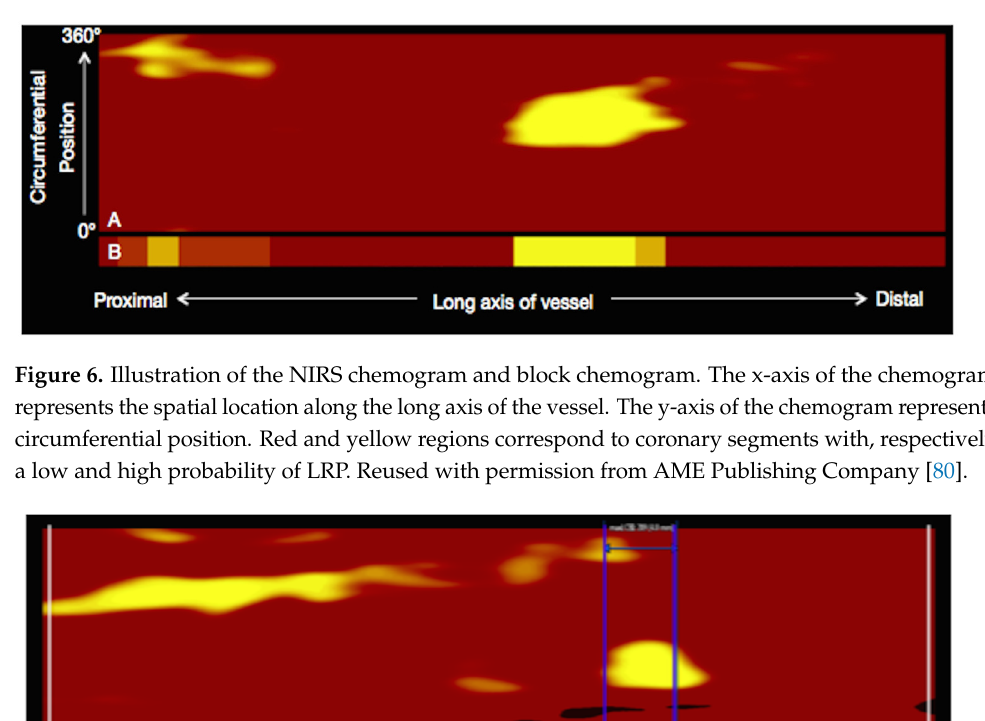
Figure 6. Illustration of the NIRS chemogram and block chemogram. The x ‐ axis of the chemogram represents the spatial location along the long axis of the vessel. The y ‐ axis of the chemogram rep ‐ resents circumferential position. Red and yellow regions correspond to coronary segments with, respectively, a low and high probability of LRP. Reused with permission from AME Publishing Company [80].